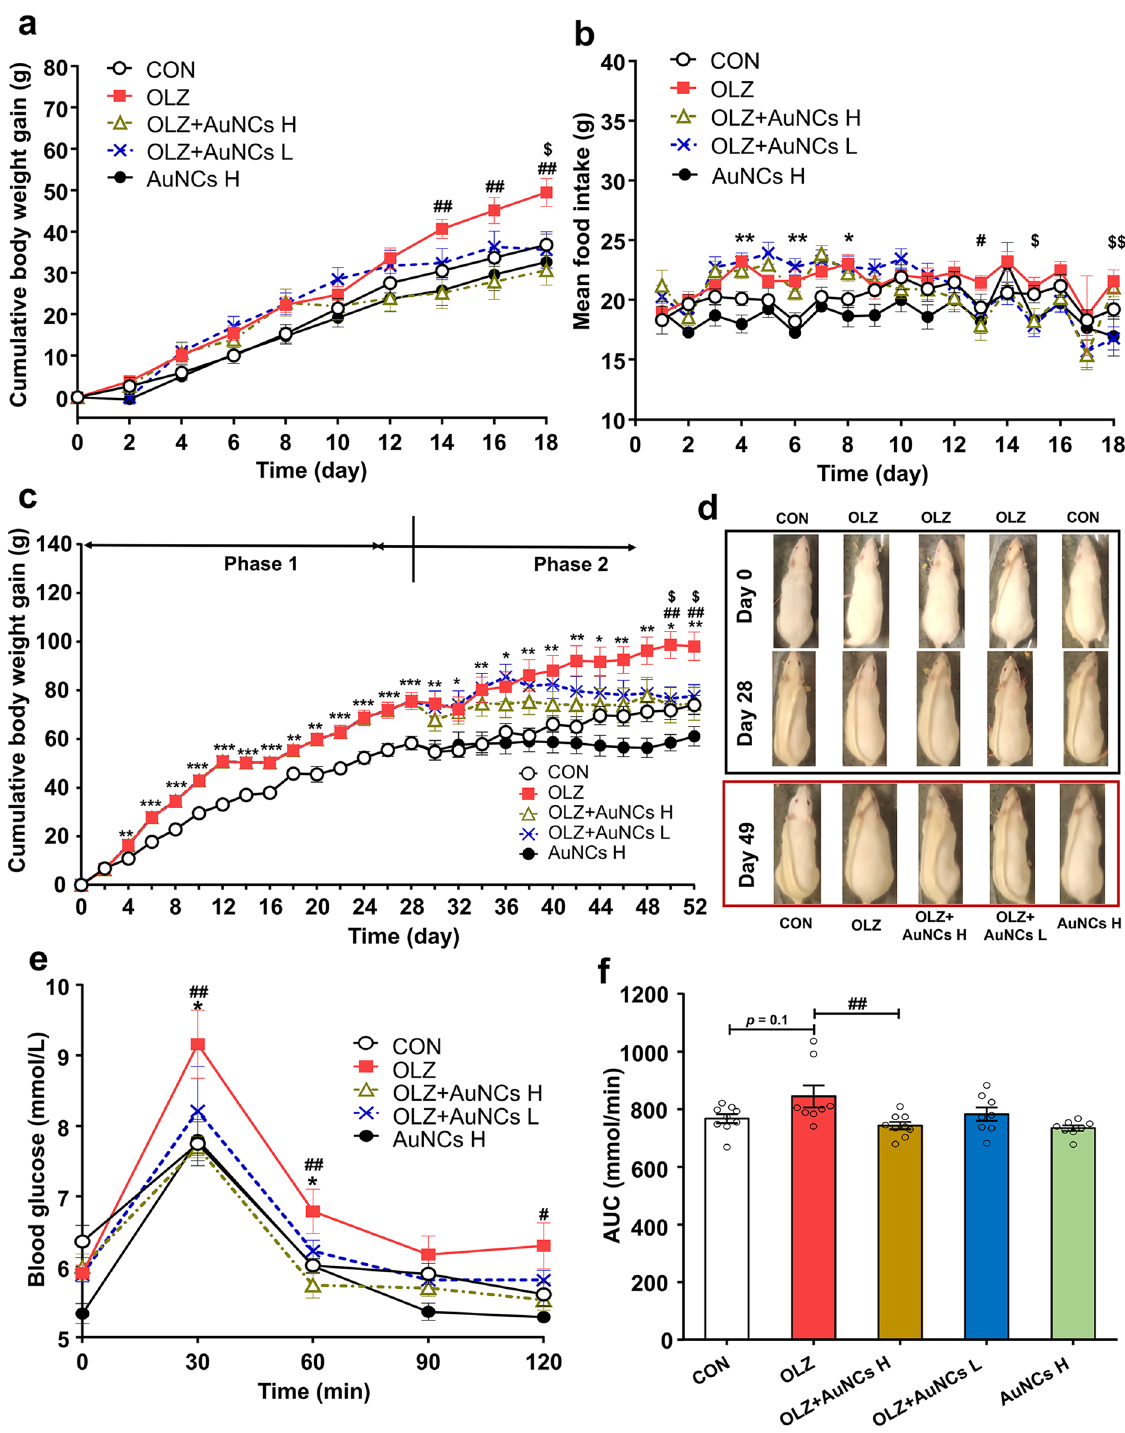
Figure 2. Effects of AuNCs on preventing and reversing the obesity induced by olanzapine and ameliorating glucose metabolic disorder caused by olanzapine. ( a , b ) Preventive effect of AuNCs on olanzapine-induced weight gain and food intake in rats. ( c , d ) Effects of AuNCs on established obesity induced by olanzapine administration in rats. ( e , f ) Effects of AuNCs on olanzapine-induced glucose metabolism examined by an intraperitoneal glucose tolerance test (IPGTT) in rats. All data were presented as mean ± SEM, n = 9–14/ group. * p < 0.05, ** p < 0.01, *** p < 0.0001, OLZ vs. CON; # p < 0.05, ## p < 0.01, OLZ + AuNCs H vs. OLZ; $ p < 0.05, $$ p < 0.01, OLZ + AuNCs L vs.